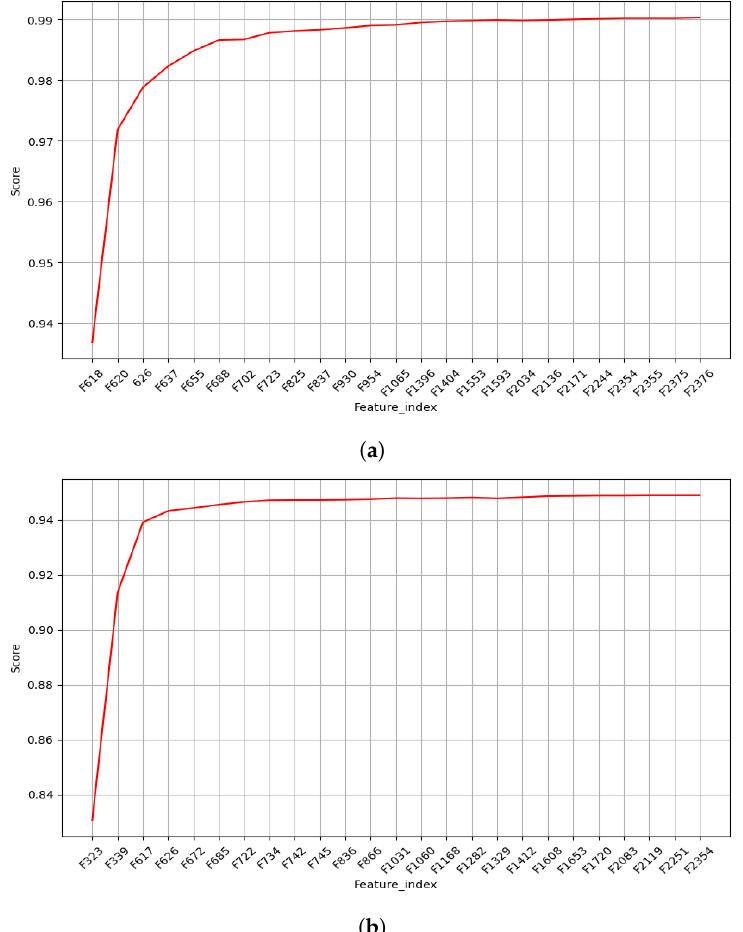
Figure 5. List of selected features and their scores. ( a ) SFS features for malware detection; ( b ) SFS features for malware